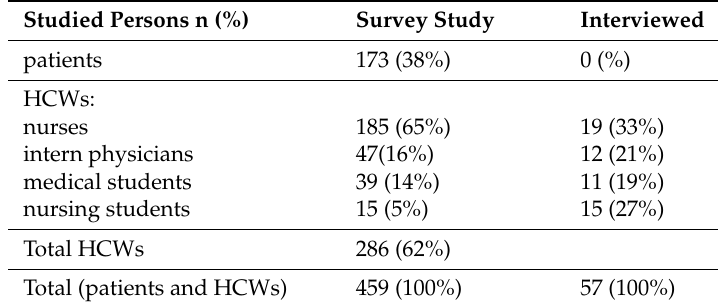
Table 1. Participants of the study divided into surveyed questionnaires and interview questionnaires. Studied Persons n (%) Survey